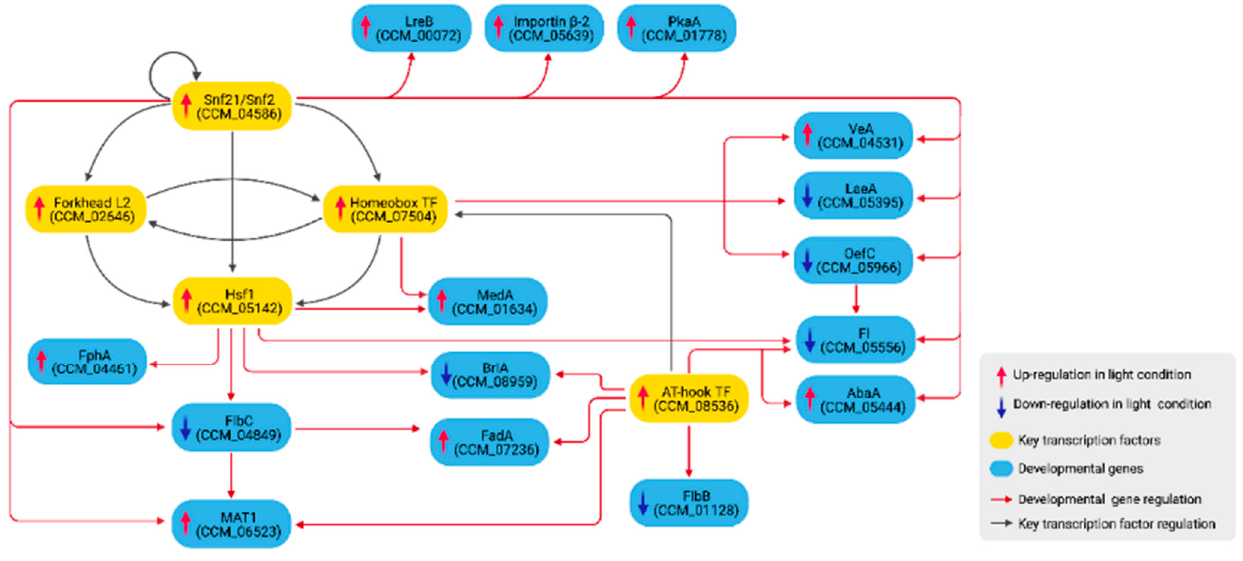
Figure 5. The regulatory sub-network of growth and developmental genes controlled by the key TFs.